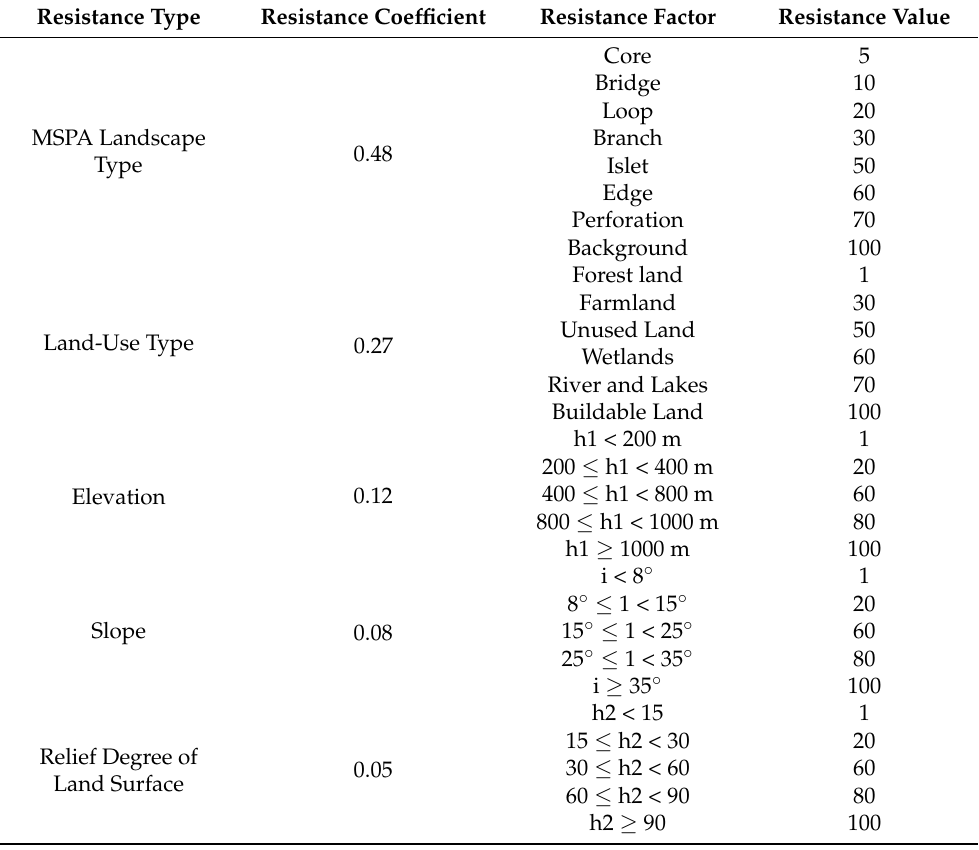
Table 2. Resistance values and coefficients of each